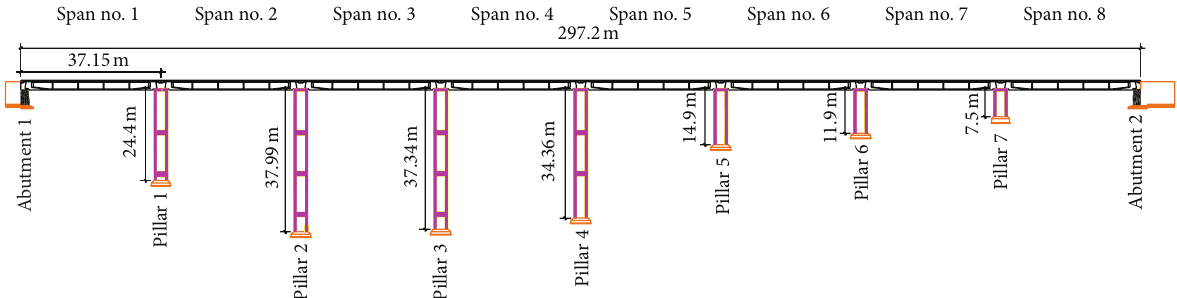
Figure 1: Scheme of “Ponte degli Alpini.”